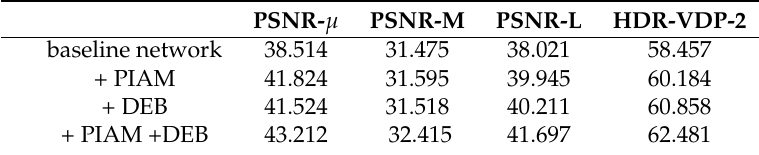
Table 3. Ablation study on different components of the proposed HDR imaging